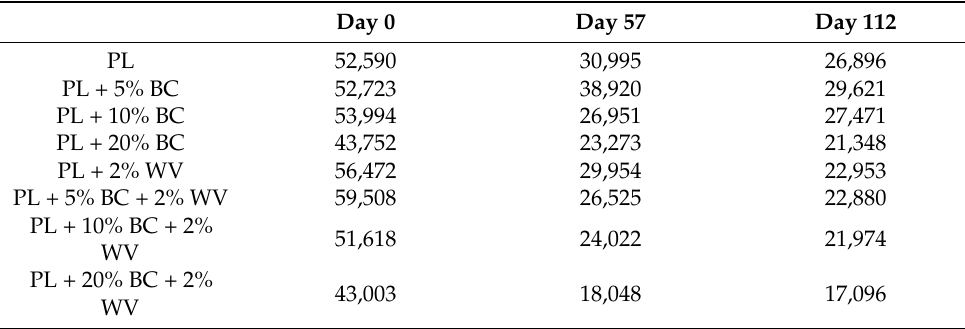
Table 2. Potassium concentrations (kg/ha) over time for poultry litter blends.